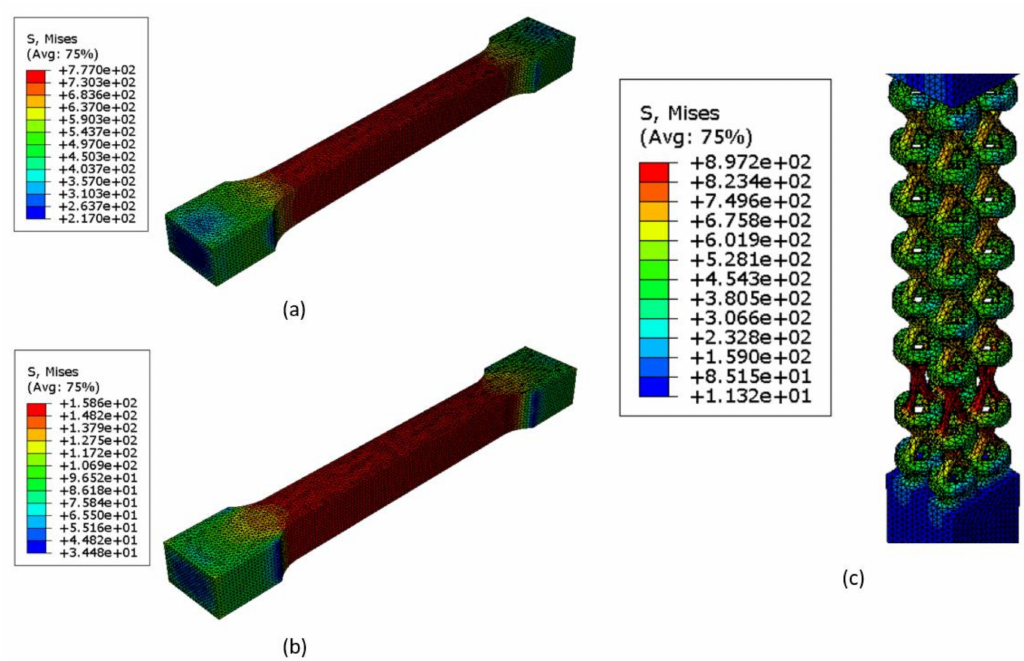
Figure 5. Deformation contour plots of FEA for tension samples: ( a ) bulk 316L stainless steel dog-bone; ( b ) bulk dissolvable aluminum dog-bone; ( c ) 316L stainless steel lattice dog-bone.